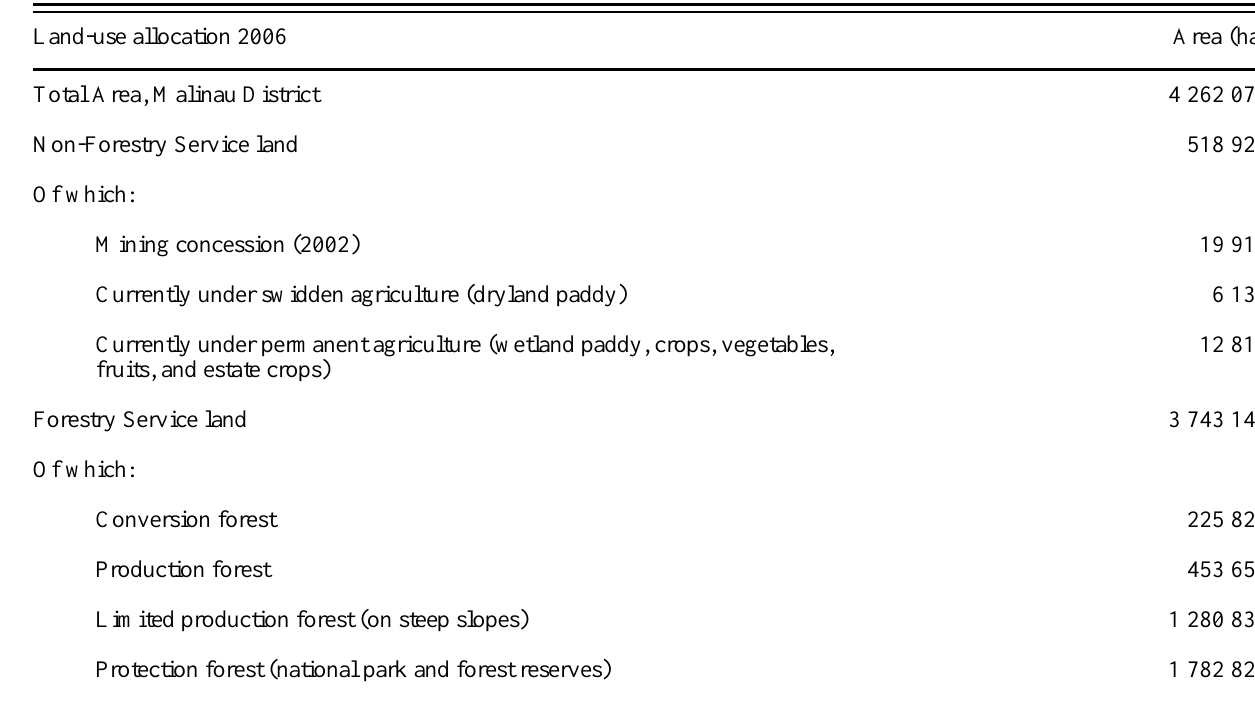
Table 1. Land-use allocation for Malinau (source: Dinas Kehutanan dan Perkebunan Kab. Malinau 2006, TGHK revised 2002 for mining